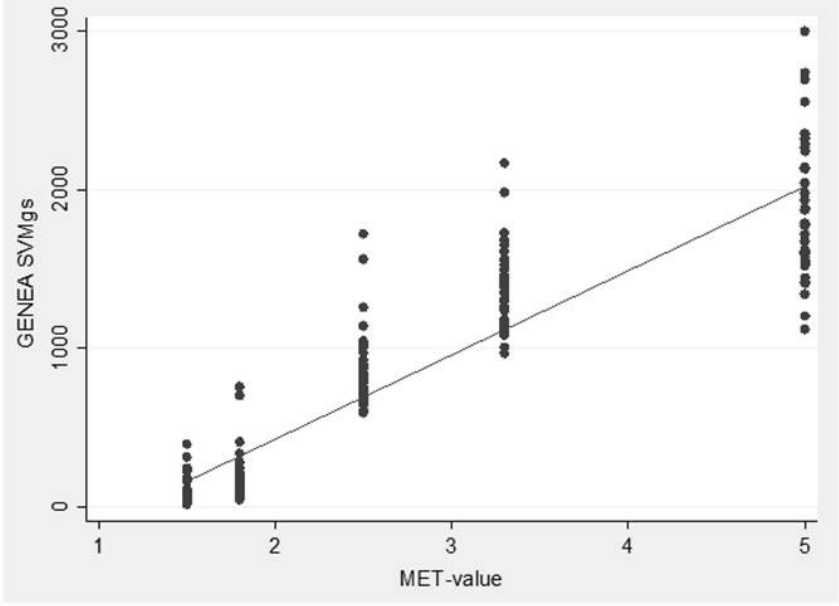
Figure 3. Scatter plot displaying MET-values of activities performed during the calibration (x-axis) and average GENEA-output in SVMgs (y-axis) for each specific activity, n=22 (44 measuring